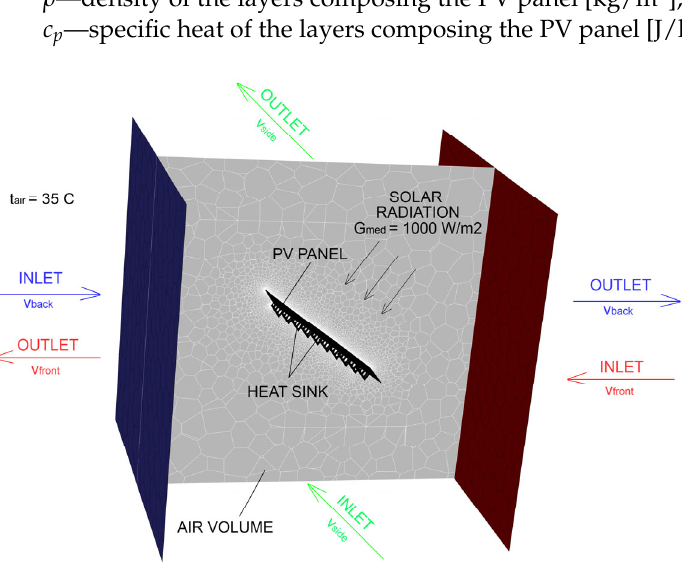
Figure 3. The geometry and set ‐ up of the numerical simulation domain.